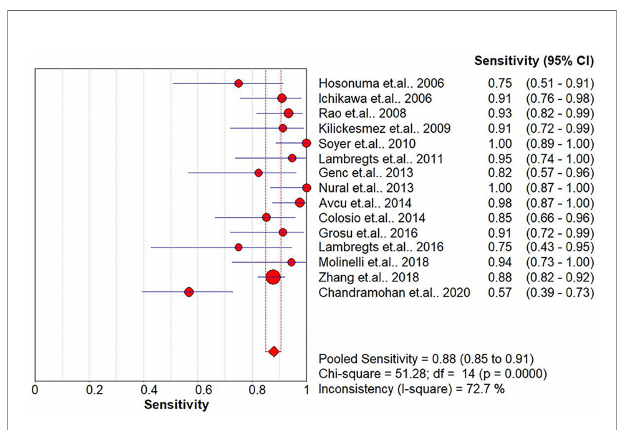
FIGURE 4 | Summary of the positive likelihood ratio of the included studies.